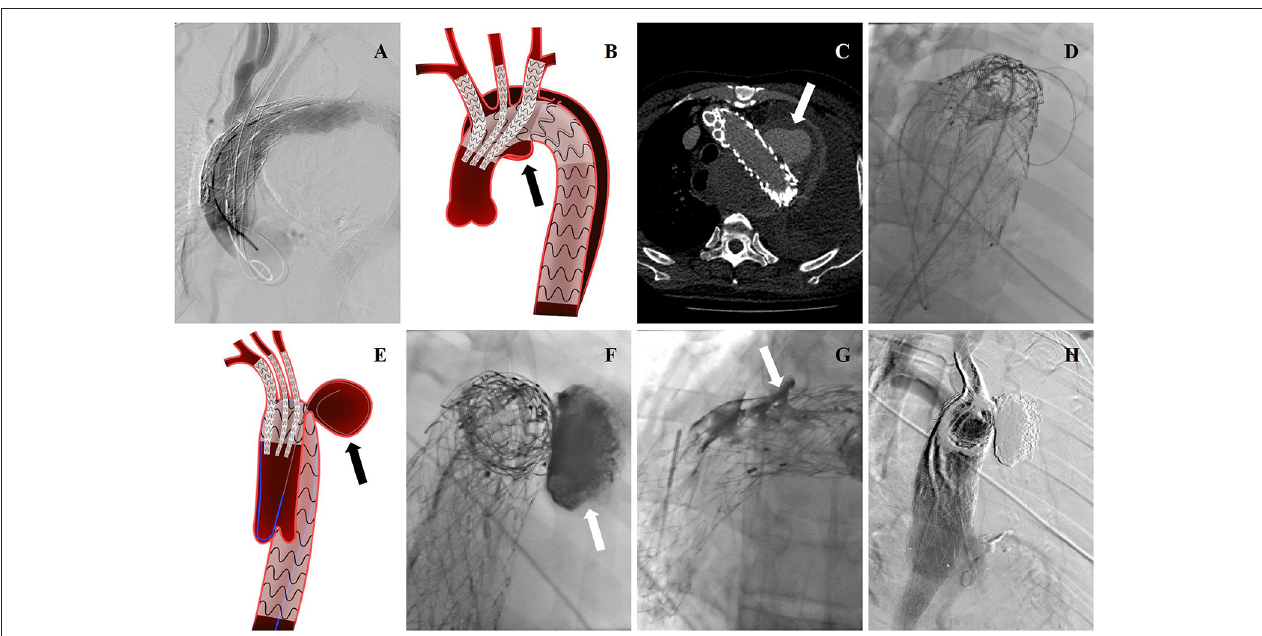
FIGURE 1 | (A) Intraoperative DSA showing this patient was treated with TEVAR before, and a new pseudoaneurysm occurred. cTEVAR was performed in the first operation. (B) Endovascular treatment was shown by cartoon graph. (C) Post-operative EL-I was revealed by CTA reexamination, and pseudoaneurysm (arrow) almost occupied the entire left thoracic cavity. (D) The guidewire and catheter entered into FL through gutters by choosing femoral artery as the access artery in the second operation. (E) The cartoon graph demonstrated the method of selecting guidewire into FL (arrow). (F) Onyx glues were injected into FL through a microcatheter (arrow). (G) Onyx glues were injected into gutters (arrow). (H) Endoleak disappeared in the last